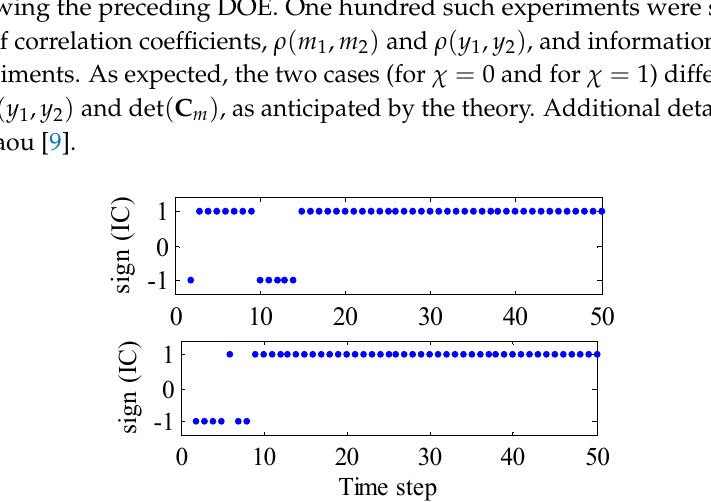
Figure 7. Satisfaction (+1) or violation ( − 1) of IC for the identified model when χ = 1 (top row) and χ = 0 (bottom row). Integral controllability (IC) checked via Equation (11) for both cases.